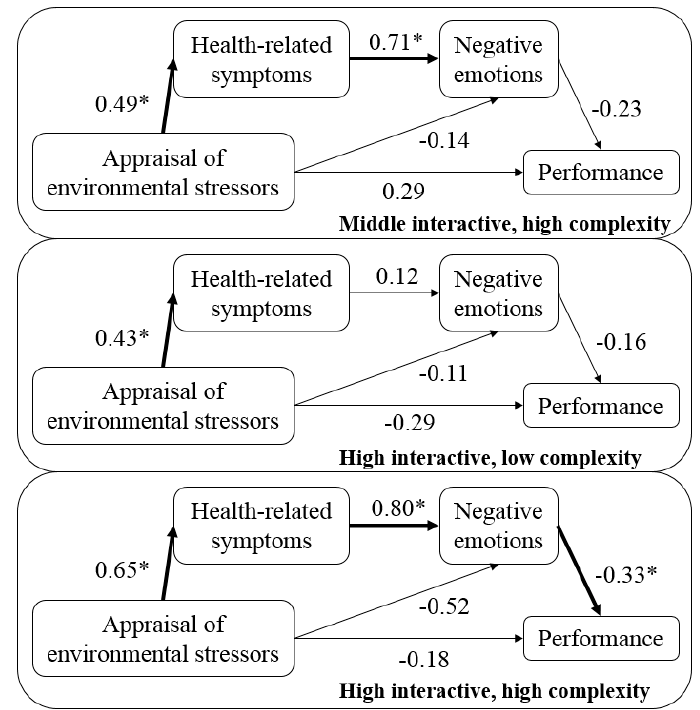
Figure 2. Multi-level multi-group structural equation modeling. * p < 0.05.